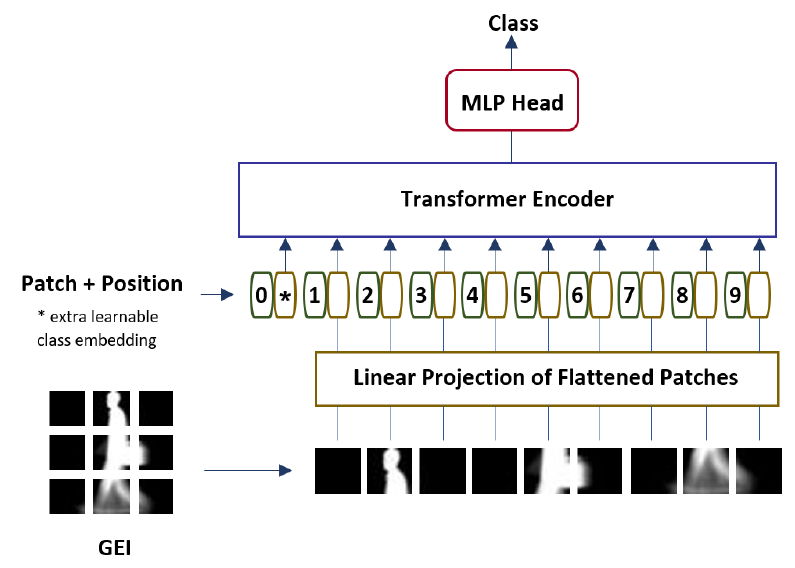
Figure 1. Architecture of the proposed Gait-ViT method.